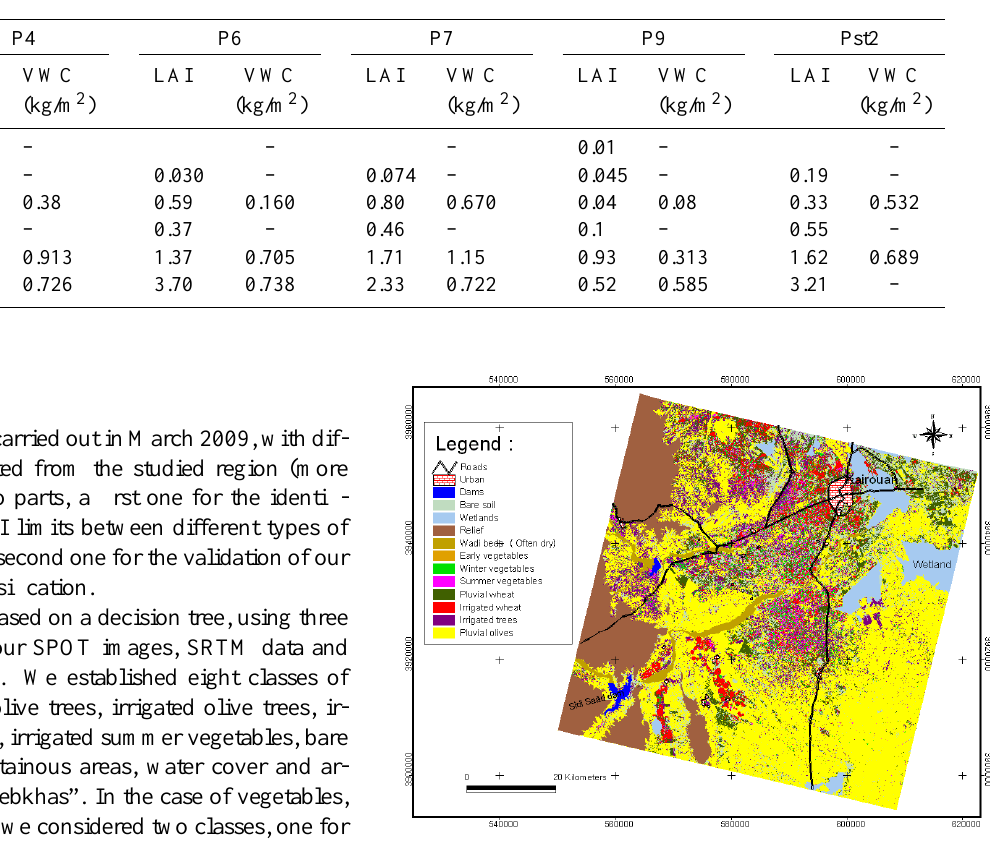
Table 4. Leaf Area Index and vegetation water content measurement.